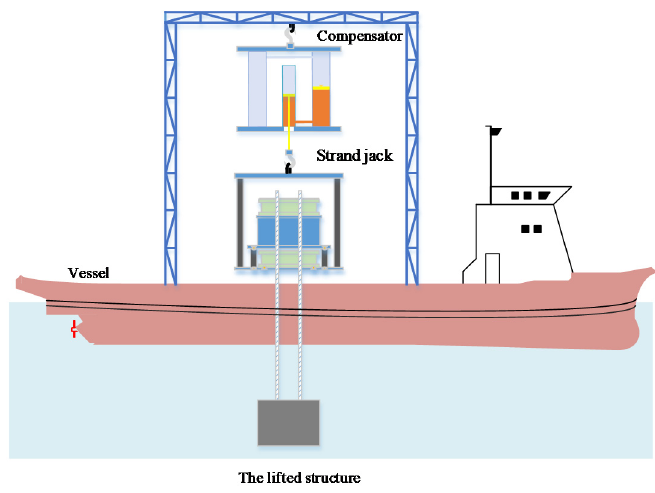
Figure 2. Schematic layout of the strand jack lifting system.